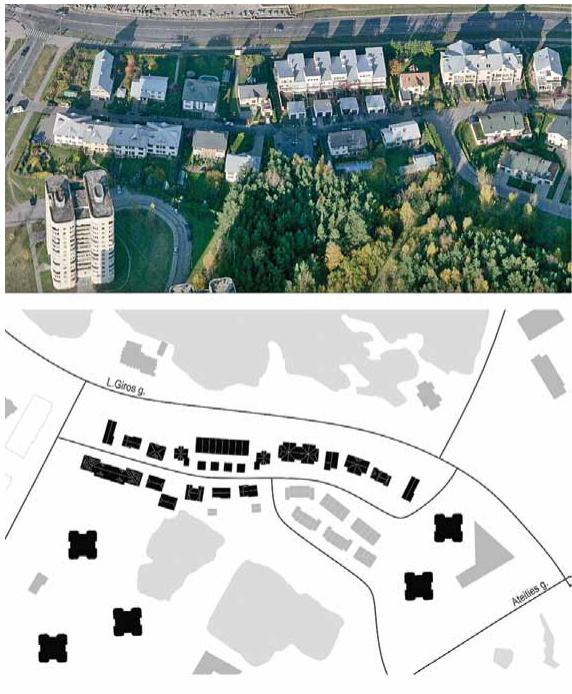
Fig. 16. Block of the monolithic single family homes in fabijoniskes (designed by archit. of „Monolith“ (Experimental association of Design and Construction), constr. st. in